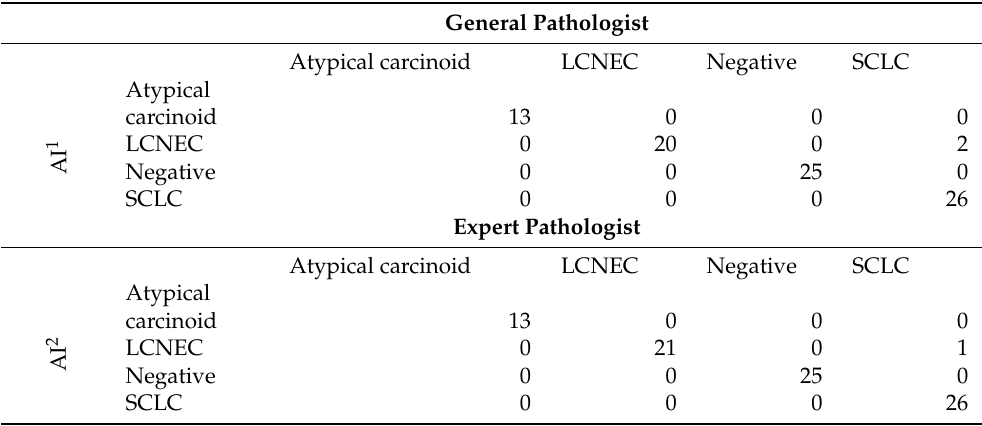
Table 1. Confusion matrix of the prediction of the AI algorithm versus the pathologist (combined cases have been excluded). General Pathologist Atypical carcinoid LCNEC Negative SCLC Atypical 1 A I